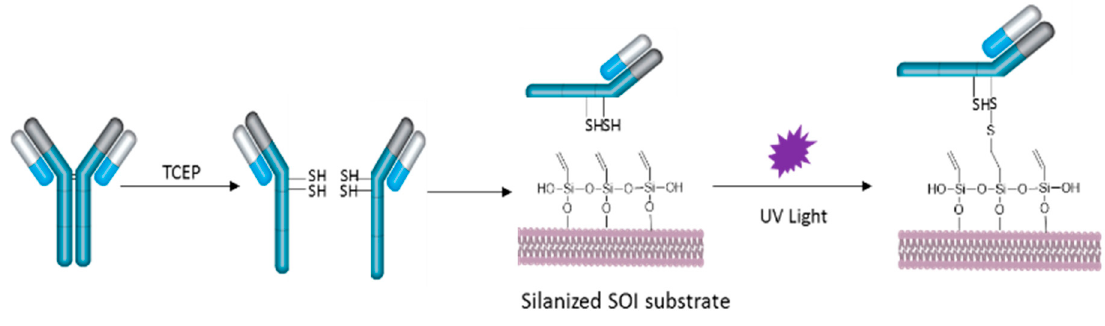
Figure 3. Schematic representation of the process used for the covalent immobilization of the haBSA antibodies on the PBG sensors